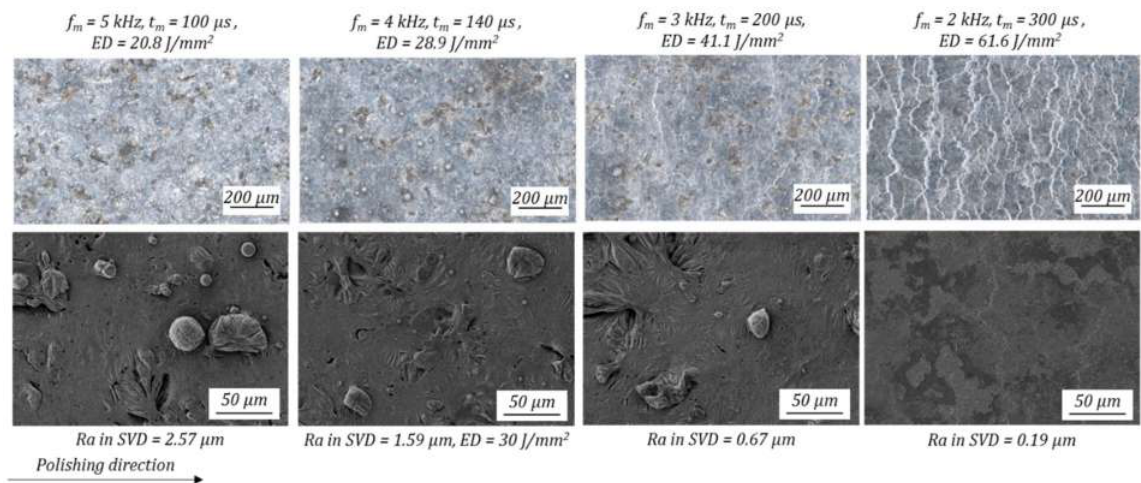
Figure 15. Microscopic differences of the achieved surface behaviour after laser polishing, depending on the energy density ED at the centre of the polishing fields. First row light microscopic images with a 100-fold magnification, second row SEM images with a 500-fold magnification.